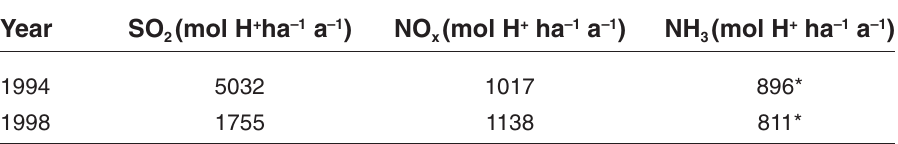
, NO , and NH in 1994 and 1998 (mol H + ha –1 a –1 )[10,11,22] 2 x 3